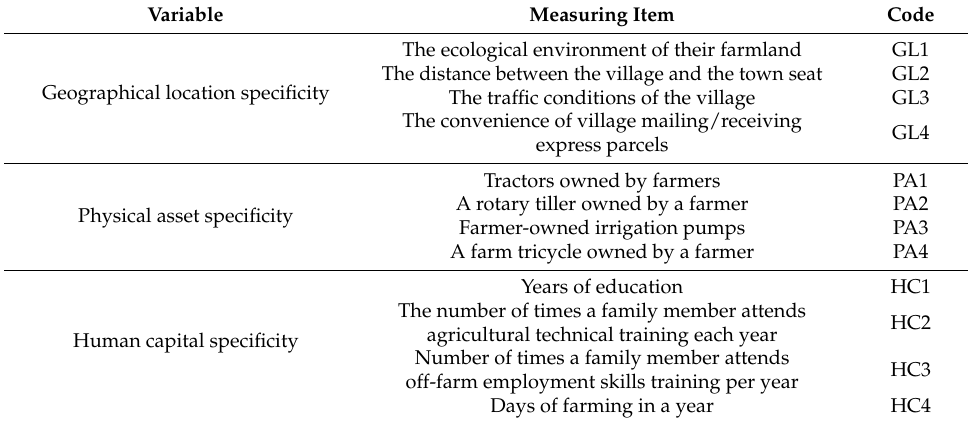
Table 1. Measurement items of the three dimensions of asset